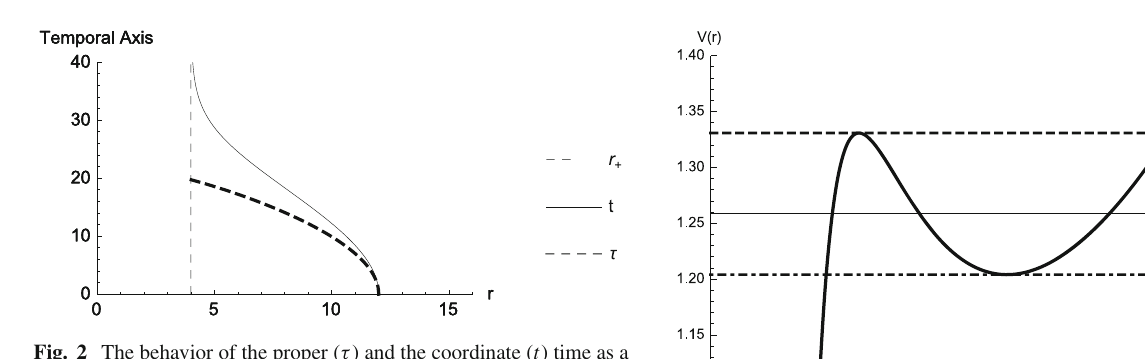
Fig. 1 The behavior of V ( r ) for radial particles ( L = 0) left panel, and non-radial particles ( L = 10) right panel, as a function of r , with M = 2, and m p = 1